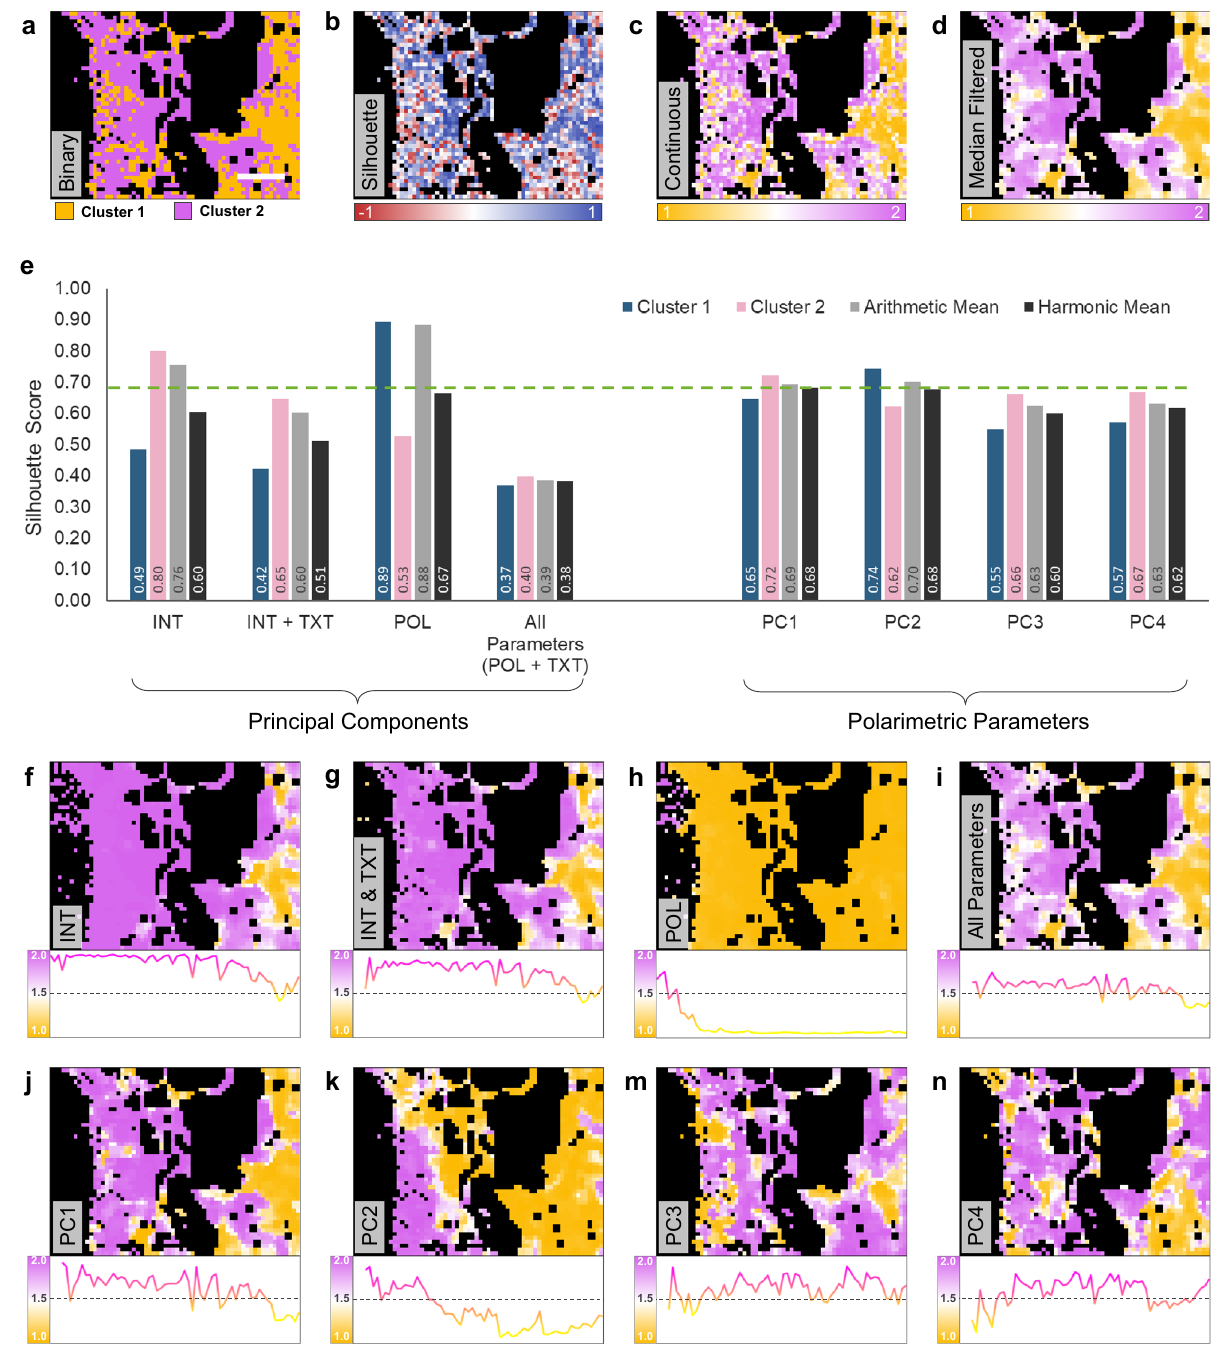
Figure 3. K-Means clustering of lung tissue. K-Means clustering was performed using all polarimetric and texture parameters for all sub-images, resulting in a binary cluster map ( a ). A silhouette score map of the K-Means results was generated to assess clustering performance ( b ). The binary and silhouette maps were combined into a single map of a continuous variable ranging from 1 (cluster 1) to 2 (cluster 2) using a mathematical transformation ( c ). Median filter of the continuous map provides for better visualization of the clusters ( d ). Performance of 8 different data subsets was assessed using silhouette scores of each cluster ( e ). The green dashed line indicates the largest silhouette score harmonic mean corresponding to PC1 and PC2. Median filtered maps of the data subsets highlight the 2 dimensional distribution of clusters, and their vertically averaged plots illustrate horizontal cluster variations ( f – n ). Scale bar 500 µ